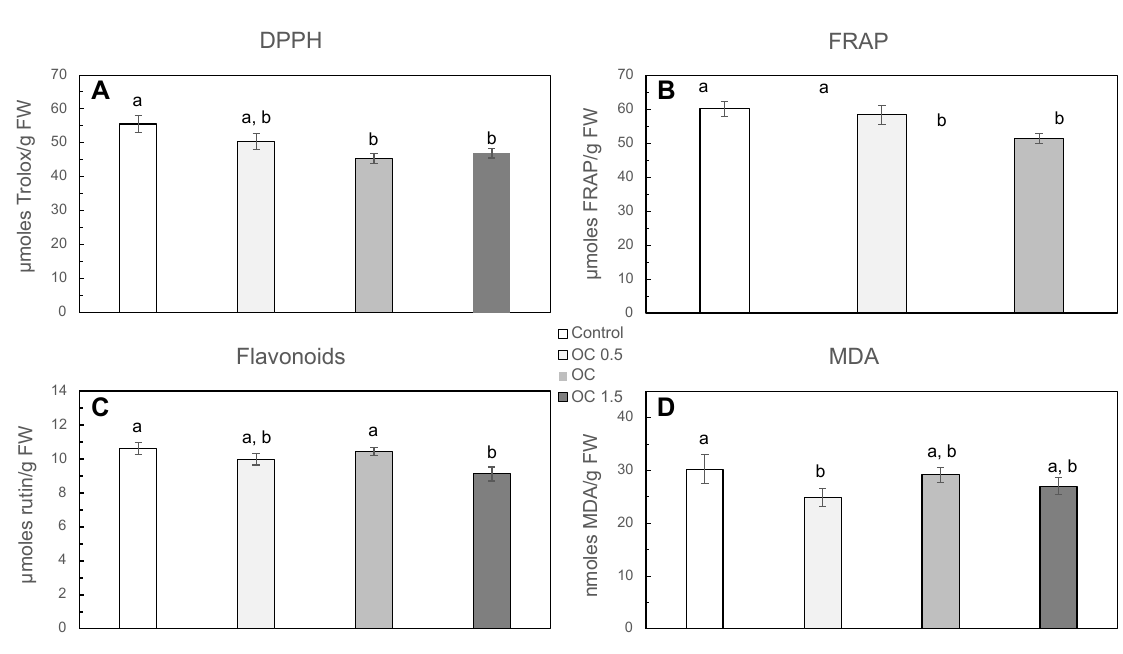
Figure 2 Effect of foliar fertilizer treatment on the antioxidant capacity of saffron leaves ( Crocus sativus L.). Values are represented as mean ± SE ( n = 3). e mean values marked by the same letter are not significantly different at p < 0.05 as determined by Tukey’s test. FW – fresh weight; OC – optimal concentration; DPPH – 2,2-diphenyl-1-picryl-hydrazyl; FRAP – ferric reducing antioxidant power assay; MDA –